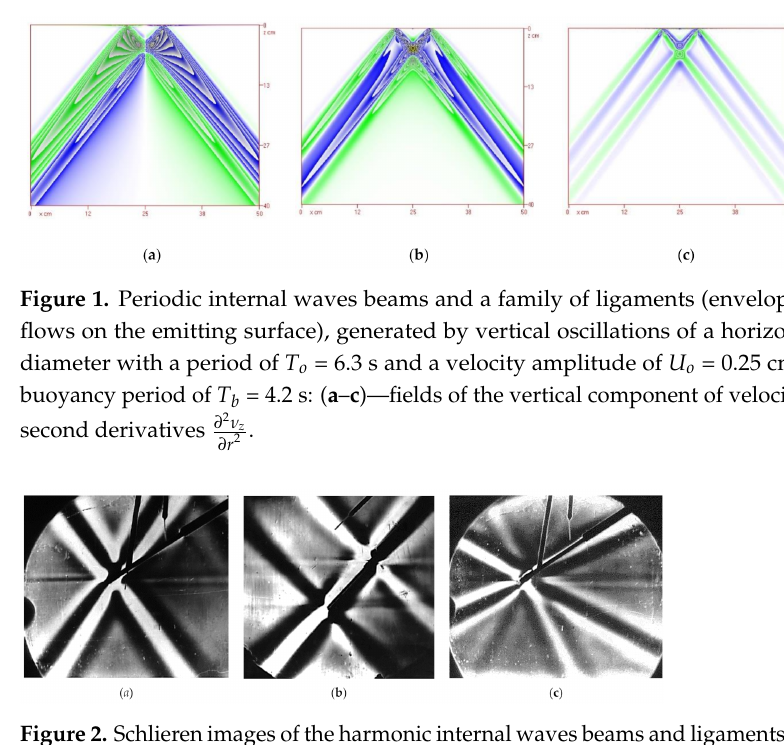
Figure 2. Schlieren images of the harmonic internal waves beams and ligaments (horizontal interfaces) generated by the sloping band placed under angle ϕ = 35 ◦ band oscillating along its plane: ( a )— period of buoyancy T b = 5.5 s and band oscillation T = 6.5 s, width a = 1 cm and amplitude of oscillations A = 0.15 cm, beam slope angle θ = 57 ◦ (cid:54) = ϕ —general case; ( b ) ϕ = 45 ◦ , T b = 5.5 s, T = 7.8 s, a = 6 cm, A = 0.15 cm, θ = ϕ = 45 ◦ —critical case: ( c )— ϕ = 35 ◦ , T b = 5.5 s, T = 13 s, a = 1 cm A = 0.15 cm, slope of main beam θ 1 = 25 ◦ , second harmonics beam θ 2 = 60 ◦ .